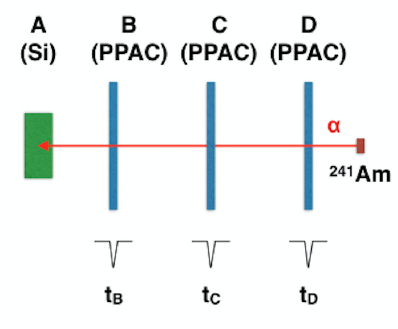
Figure 2. Setup for measuring the time resolution of the